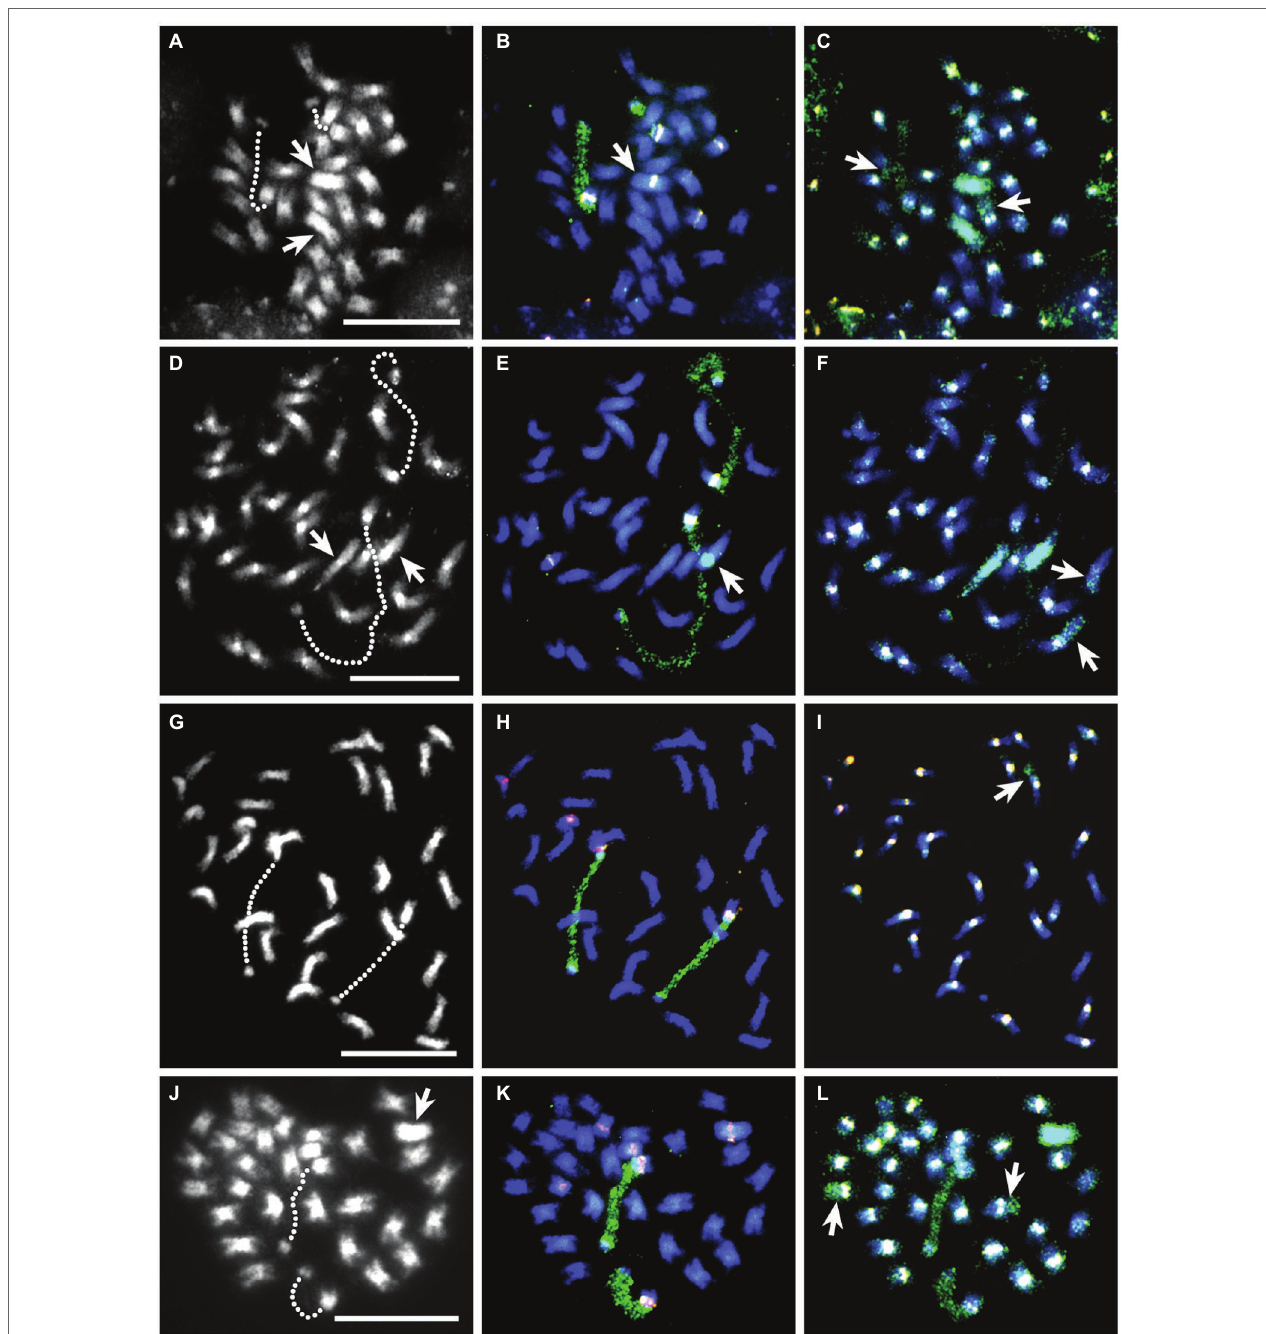
FIGURE 3 | FISH-GISH results for somatic cells of four interspecific hybrids. The left column is DAPI stained (gray scale), the center column the same cell with 5S rDNA (pink) and 18S rDNA (green) FISH probes and the right column the same cell with sequential FISH-GISH using the centromeric probe TrR350 (white) and T. ambiguum genomic DNA (green). Hatched lines in the left column show the decondensed NOR-regions of each pair of NOR-chromosomes from T. repens or T. occidentale that show as green 18S rDNA signals in the middle column. (A–C) , BC 1 -120; in (A) , the arrows show two large T. ambiguum chromosomes that were apparent following GISH in (C) . In (B) , the arrow indicates that one of the T. ambiguum chromosomes carried a 5S rDNA signal. In (C) , the arrows mark recombinant chromosomes, one of which lacks a TrR350 centromeric signal. (D–F) , BC 1 -132; in (D) , the arrows show two large T. ambiguum chromosomes that were apparent following GISH in (F) . In (E) , the arrow shows that one of the T. ambiguum chromosomes carried a condensed NOR region (detected by the 18S rDNA probe). In (F) , the arrows mark recombinant chromosomes, one of which has a very weak TrR350 centromeric signal. (G–I) , Kopu II × BC 1 -132; in (I) , the arrow shows a recombinant chromosome. (J–L) , BC 2 -133; in (J) , the arrow shows a large T. ambiguum chromosome which is visible in (L) and carries a 5S rDNA signal (K) . In (L) , the arrows show two recombinant chromosomes, both with strong centromeric TrR350 signals. Bars 10 μ